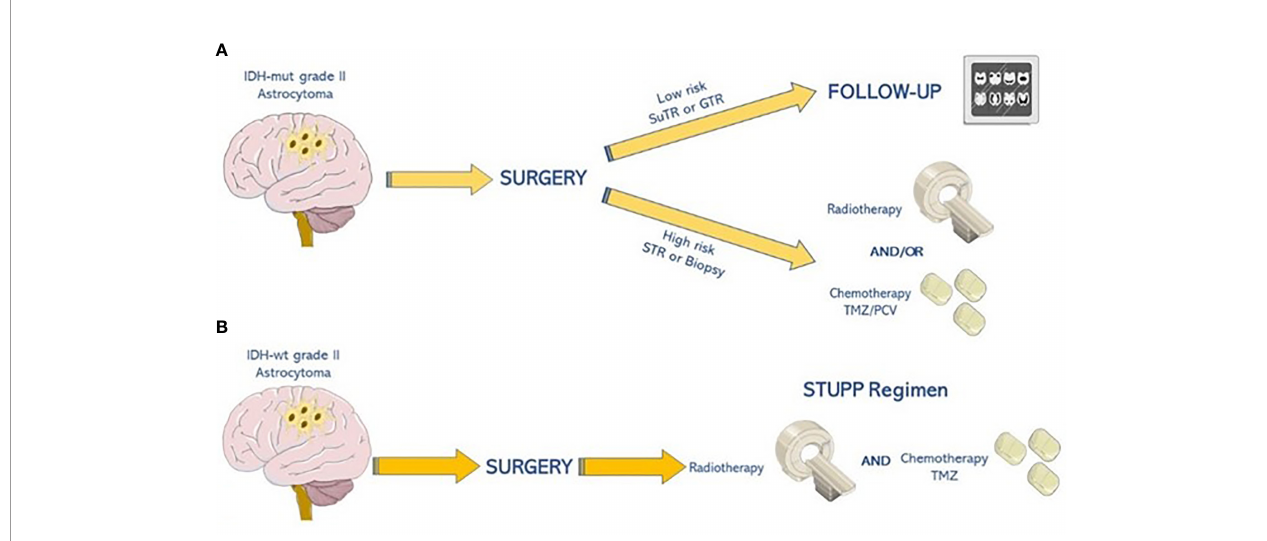
FIGURE 3 | Therapeutic algorithm for grade 2 astrocytoma. (A) Patients with IDH-mut grade 2 astrocytomas are divided into two categories (low-risk versus highrisk). Low-risk patients should undergo radiological follow-up, while high-risk ones are eligible for adjuvant therapies, such as radiotherapy (50 – 54 Gray in 1.8 Gray/fraction) followed by chemotherapy alone with temozolomide (TMZ) or procarbazine, lomustine, and vincristine (PCV). (B) Patients with IDH-wt astrocytomas undergo concomitant and adjuvant regimens based on radio-chemotherapy with temozolomide as STUPP